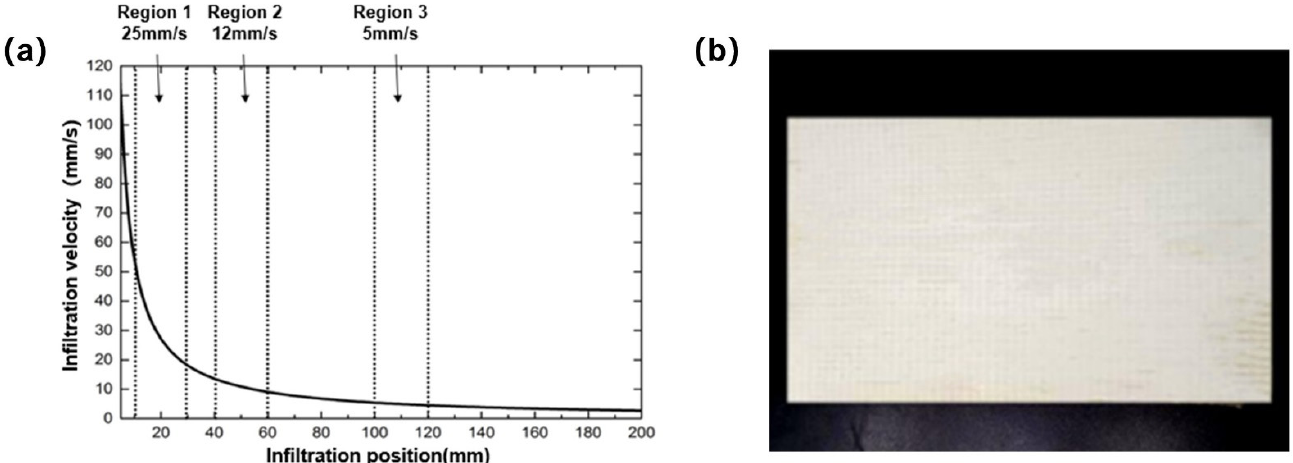
Figure 7. ( a ) Change of infiltration velocity under injection pressure of 20 kPa. ( b ) Continuous glass fiber reinforced thermoplastic pCBT matrix composites.